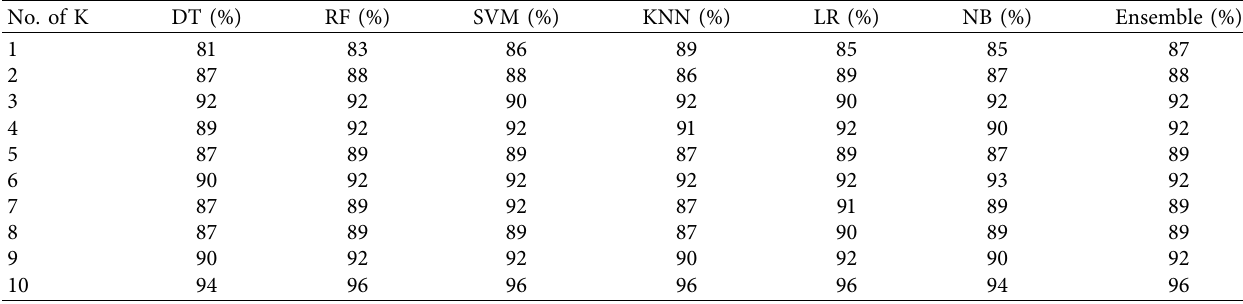
Table 3: Comparison of each algorithm and the ensemble technique with different values of k in the KMeans algorithm. No. of K